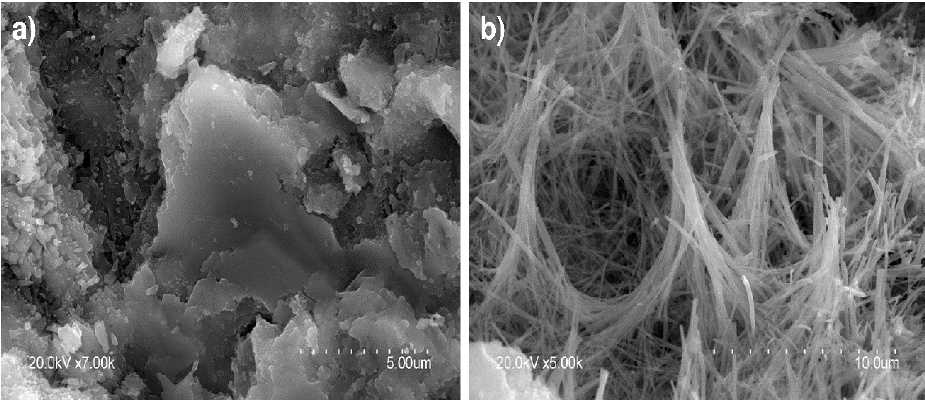
Figure 11. ( a ) Gyspum deposits (×7000) and ( b ) needle-like ettringite (×5000).